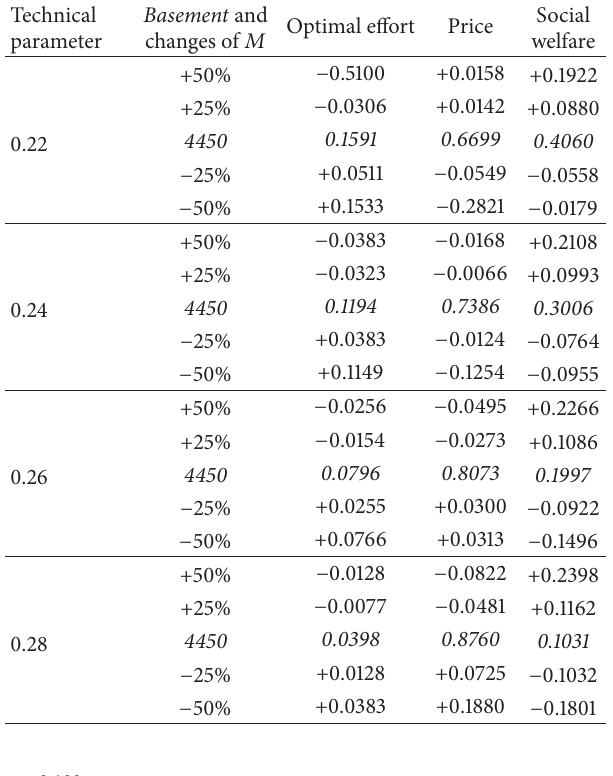
Table 2: Sensitivity analyses for social welfare versus 𝑀 .